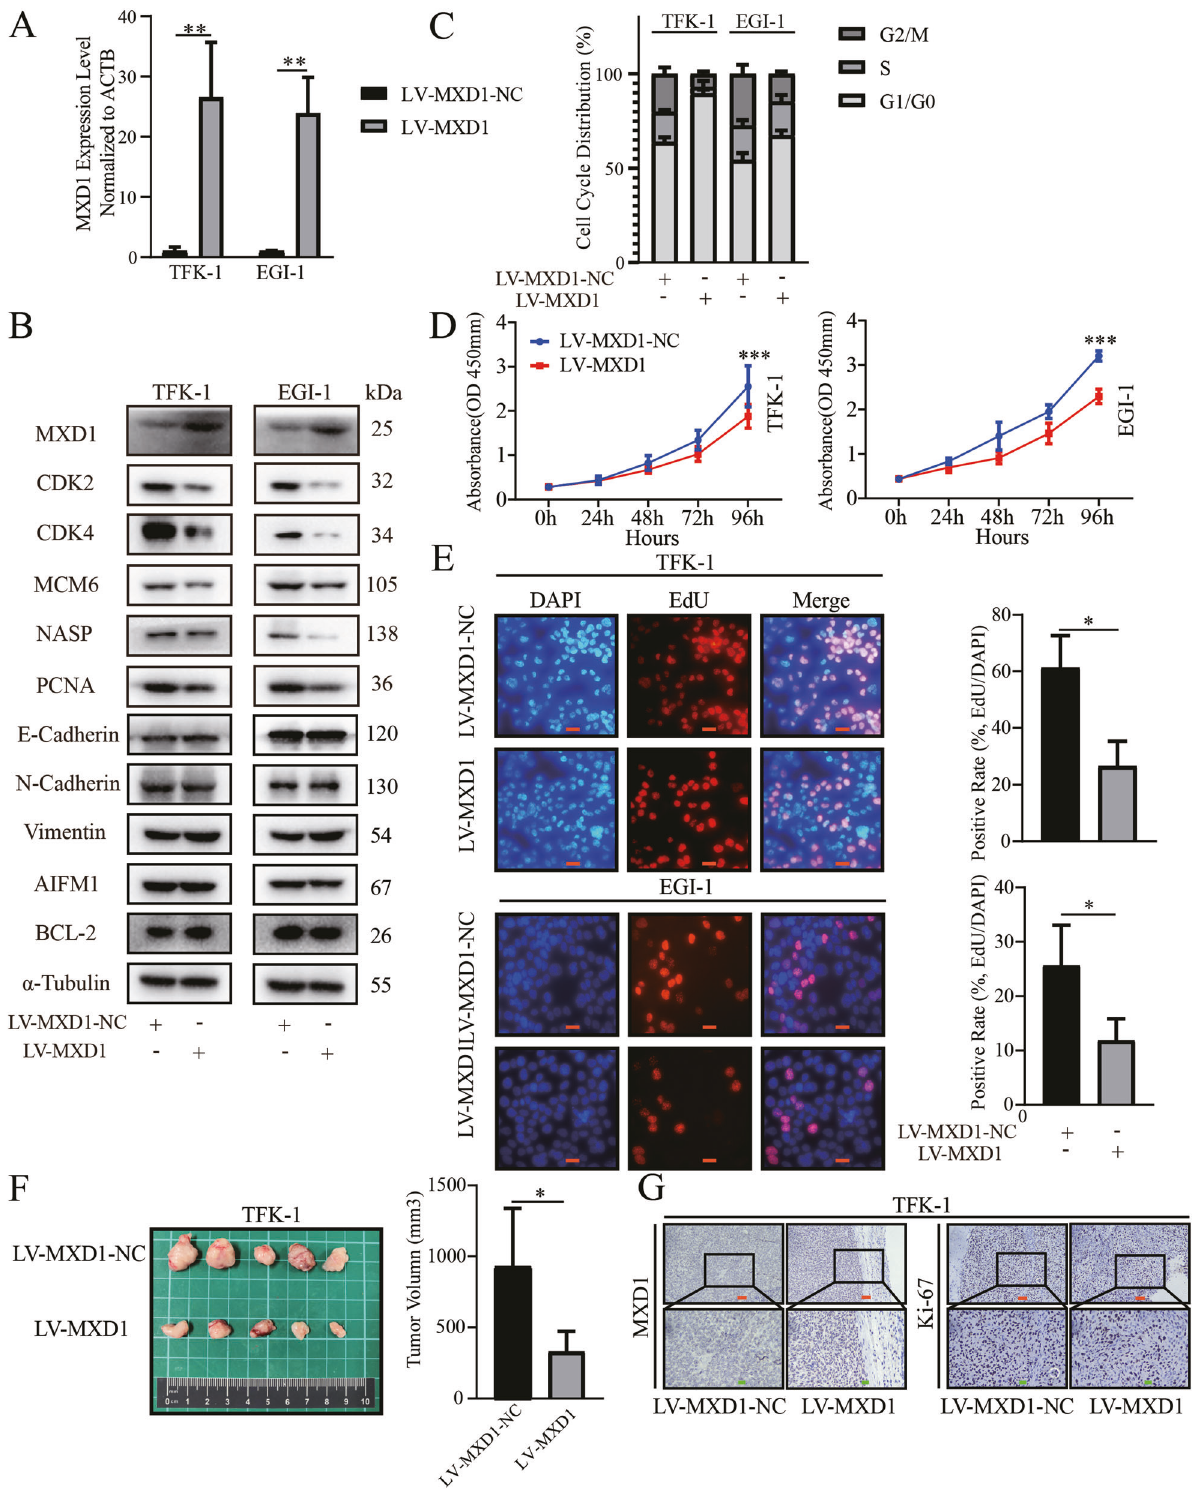
Fig. 5 MXD1 overexpression reduces the malignant behaviors of ECCA cells. A , B RT-qPCR and Western blot validated MXD1 overexpression in ECCA cells. B Western blot analysis of the expression of mitosis-related genes in ECCA cells. MXD1 overexpression failed to modulate not only the EMT-related gene expression, but also the expression of AIFM1 and BCL-2 in ECCA cells. C – E MXD1 overexpression attenuated the cell cycle C , proliferation D , E of ECCA cells. F MXD1 overexpression decreased the tumor volumes in mice. G Immunohistochemistry analysis of MXD1 and Ki67 expression in the xenograft tumors from nude mice. Data are representative images of each group from three separate experiments. * P < 0.05. ** P < 0.01. *** P < 0.001. Orange bar, 50 μ m. Green bar, 20 μ m.